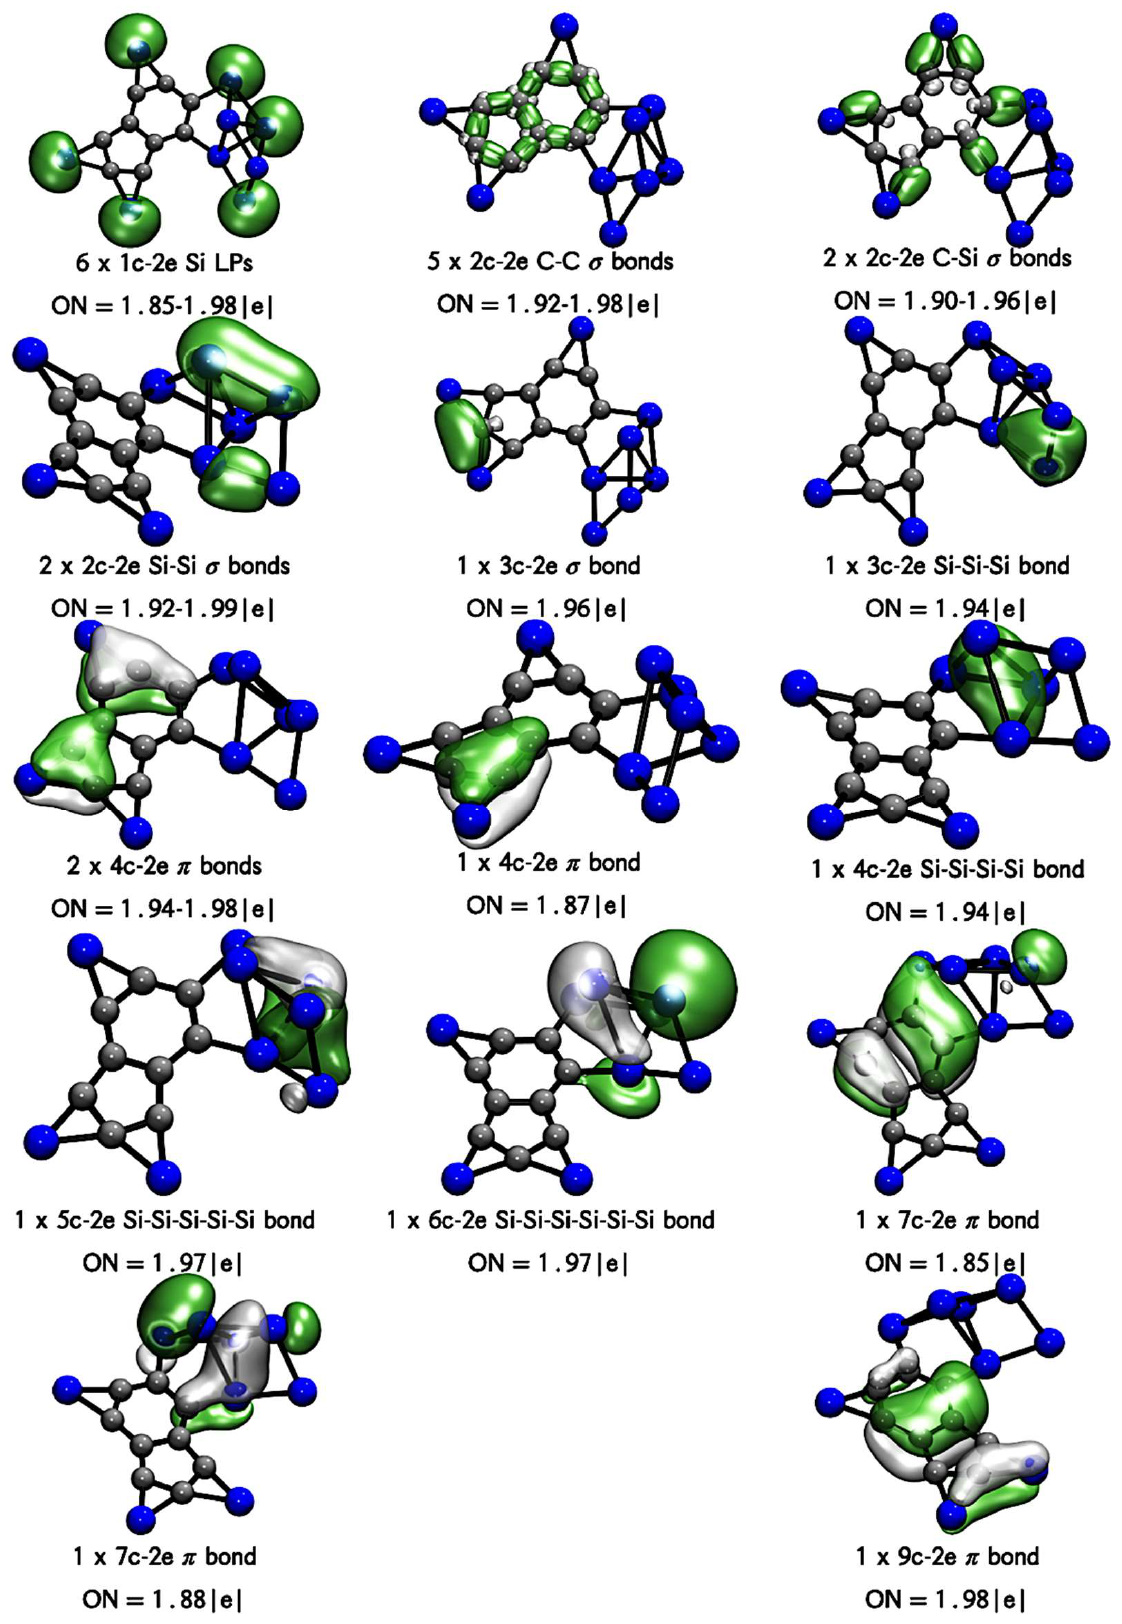
Figure 5. AdNDP bonding pattern of cluster Si 9 C 9 . Occupation numbers (ONs) are shown.